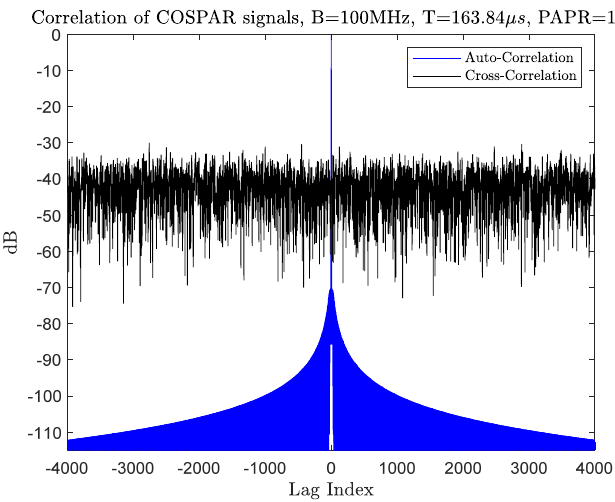
Figure 13. Normalized cross-correlation and autocorrelation of two COSPAR realizations.